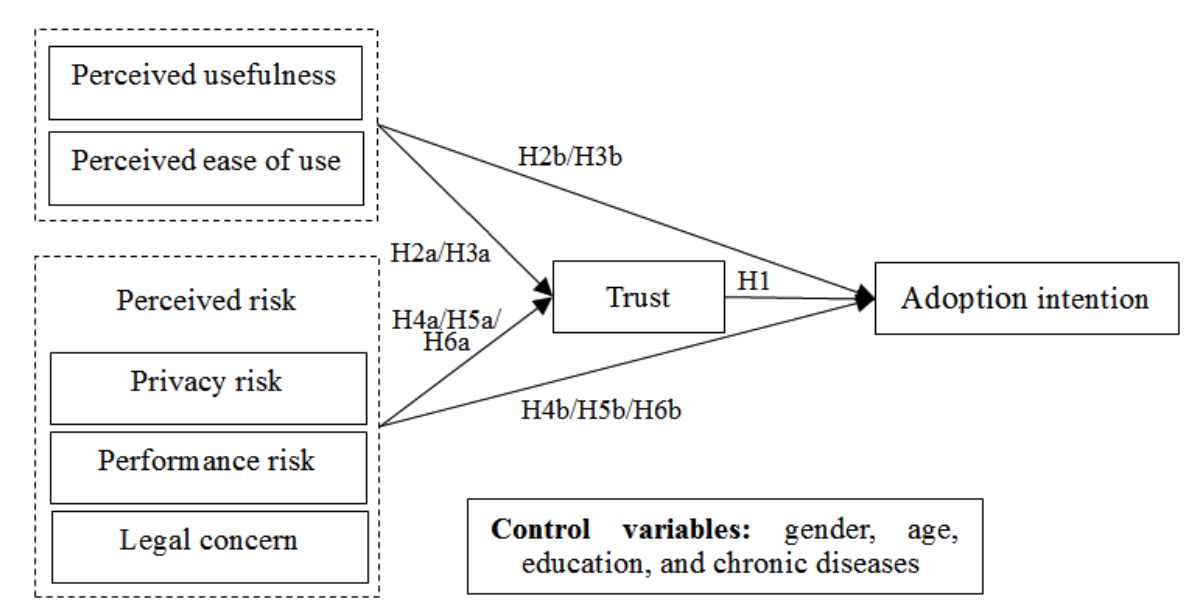
Figure 1. Proposed research model. H: